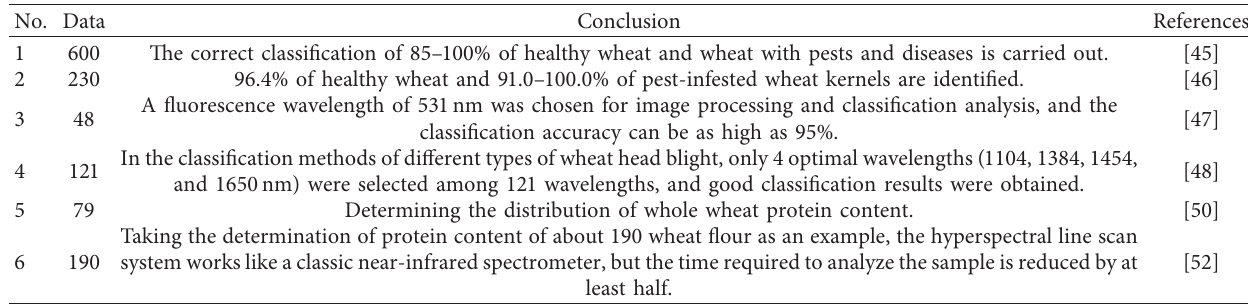
Table 3: Hyperspectral test of